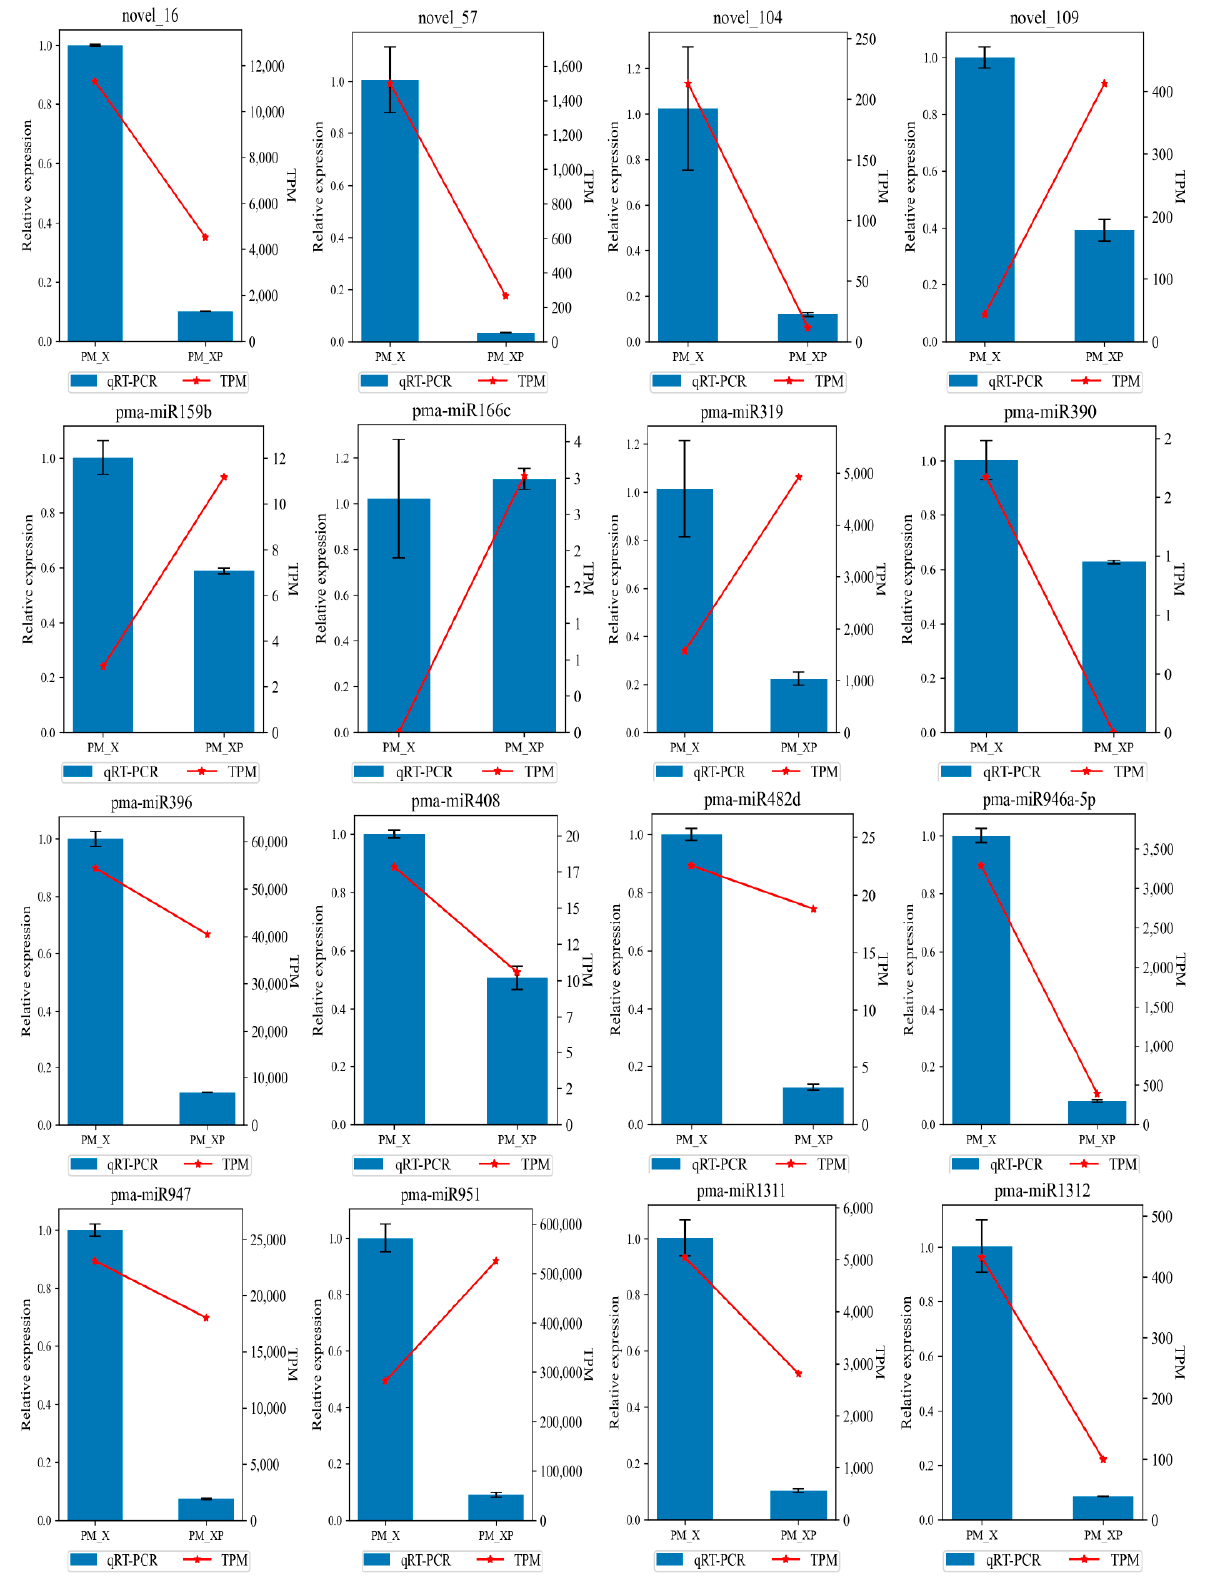
Figure 8. qRT-PCR validation of miRNAs in P. massoniana . The blue bars represent the level of expression of miRNAs calculated by qRT-PCR (left y -axis). Error bars represent the standard errors of three technical replicates. The relative expression obtained by sRNA sequencing is shown by red lines (right y -axis).